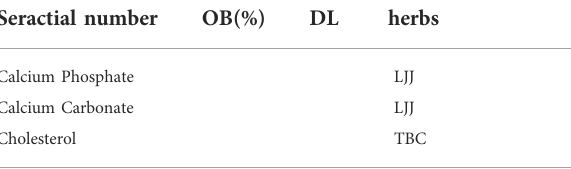
TABLE 1 ( Continued ) Drug composition of Guben Zenggu granule. Seractial number herbs